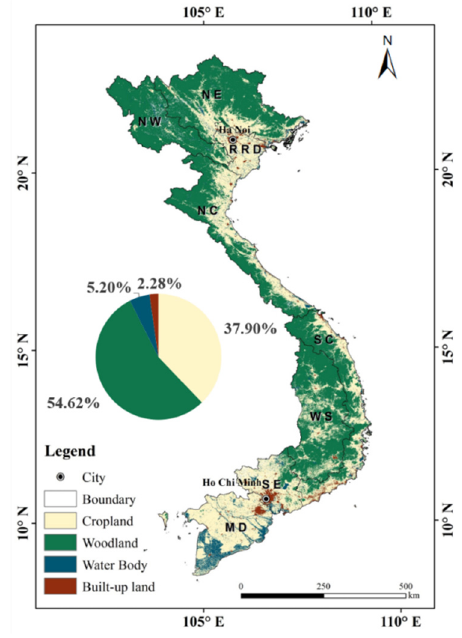
Figure 4. Land use/land cover map in Vietnam in